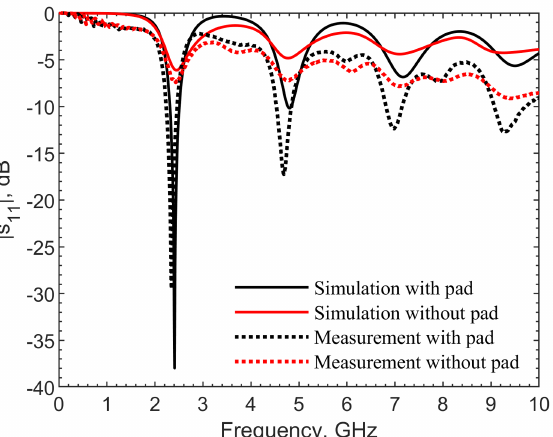
Figure 14. Comparison of measurements and simulations for tuned ( d = 1.9 mm) and untuned loop resonators, both with U =